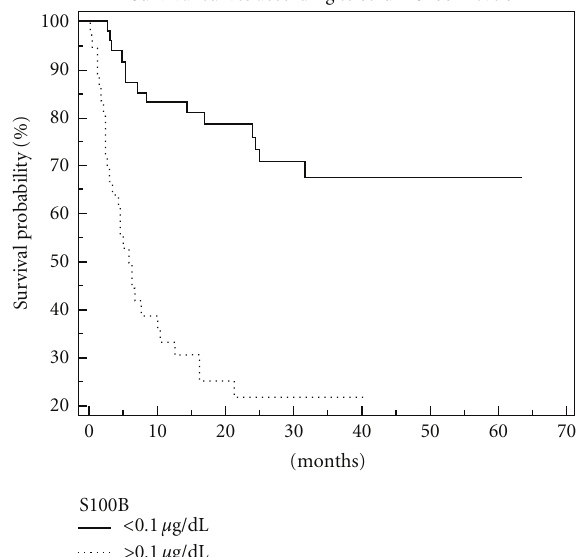
Figure 2: Survival curves according to serum S100B levels: a S100B > 0.1 μ g/dL is a bad prognosis factor (personal